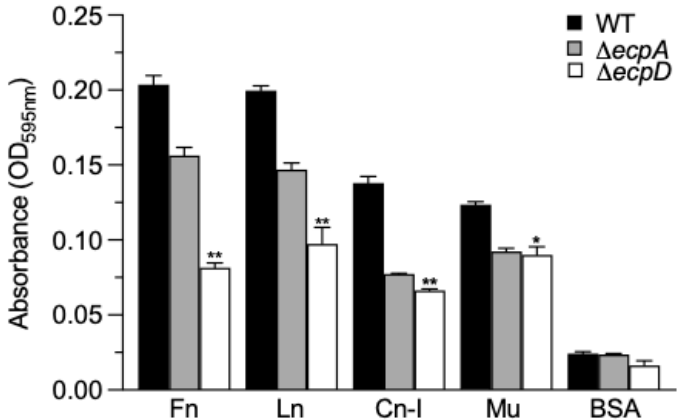
Figure 1. Binding of EPEC to ECM glycoproteins and Mu mediated by ECP. An ELISA-based test using anti-LPS O127 as a primary antibody was performed to quantitatively compare the binding of EPEC E2348/69 with the ∆ ecpA and ∆ ecpD mutant strains after 1 h of incubation at room temperature with ECM glycoproteins and Mu. BSA was used as a negative control. Data shown represent the mean of three experiments performed in triplicate on different days (Kruskal–Wallis test, * p < 0.05; ** p < 0.01).